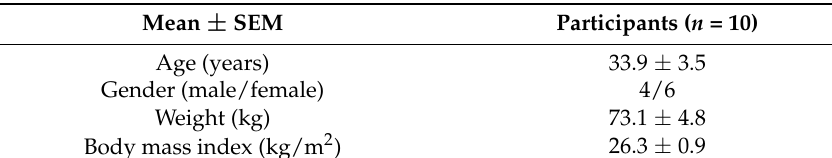
Table 2. Subject demographics in study 2.